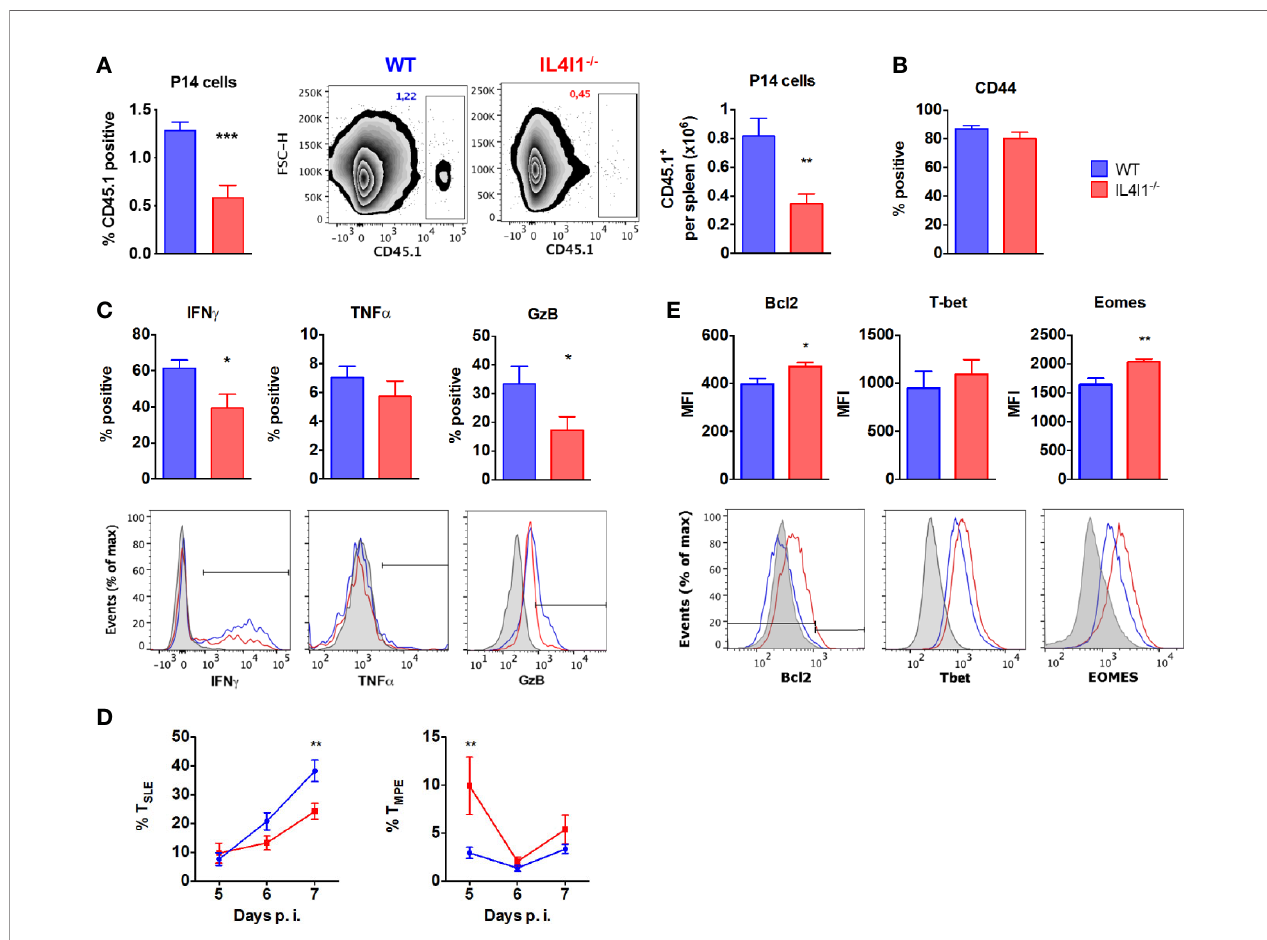
FIGURE 3 | GP33-speci fi c TCR-transgenic P14 CD8 T cells phenocopy the response of the endogenous repertoire when transferred into IL4I1 -/- hosts. CD8 T cells from CD45.1 + P14 mice were adoptively transferred into CD45.2 + congenic WT (blue) and IL4I1 -/- (red) mice one day before i.v. infection with LCMV. The expression of various markers was analyzed on CD45.1 + splenic P14 cells by fl ow cytometry (A) . Percentage and number of CD45.1 + CD8 + P14 cells in viable lymphocytes at day 5, with representative FSC/CD45.1 dot-plots (B) . Expression of CD44 by P14 cells at day 5 (C) . Percentage of CD44 + P14 cells expressing IFN g and TNF a at day 5 and GzB at day 6. The lower monoparametric histograms show representative results with the negative control in gray (NP50-stimulated cells for IFN g and TNF a , FMO for GzB) (D) . Percentage of CD127 - KLRG1 + T SLE and CD127 + KLRG1 - T MPE in P14 cells from days 5 to 7. Mean ± SEM from two to four independent experiments with three to four mice per group (E) . Mean fl uorescence intensity (MFI) for Bcl2, T-bet, and Eomes in CD44 + P14 cells at day 7. The lower monoparametric histograms show representative results with the negative control in gray (isotype immunoglobulin for Bcl2; expression on CD8 + CD44 - cells for T-Bet and Eomes). * p < 0.05, ** p < 0.005, *** p < 0.001 (Mann-Whitney, except (E) : Student t